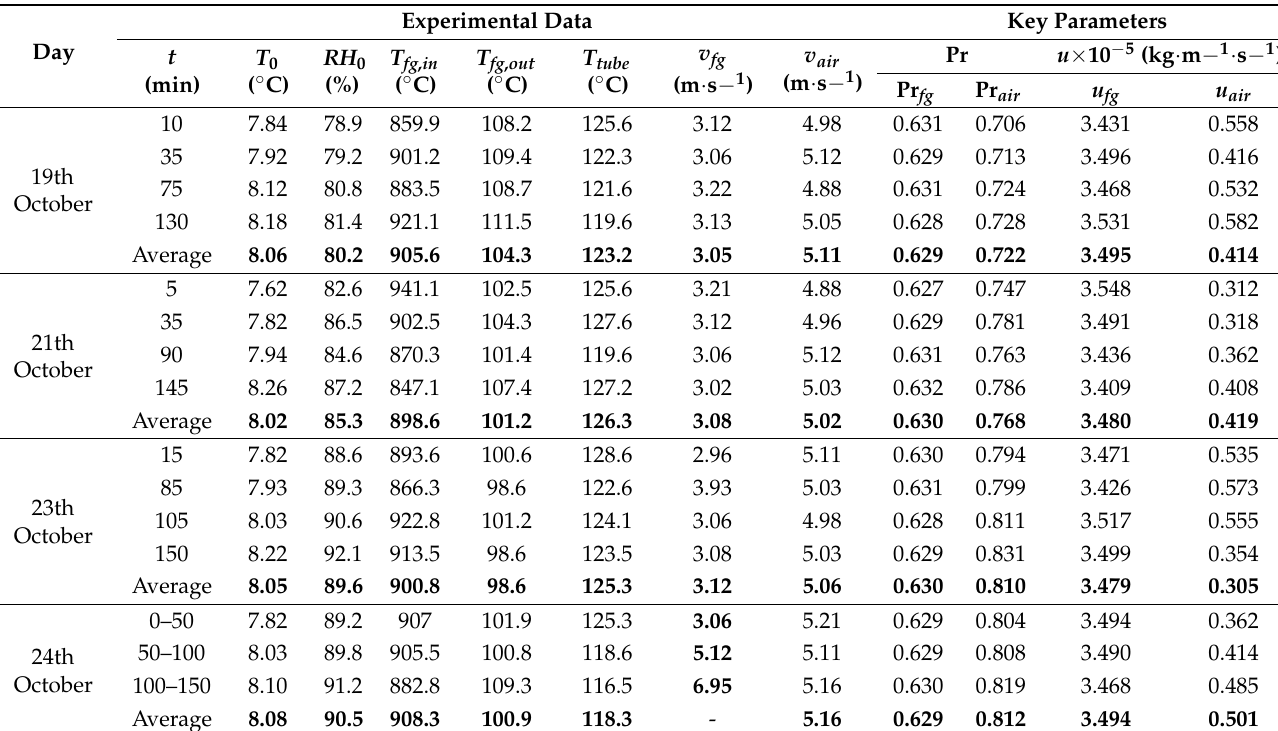
Table 3. Partial experimental data and related